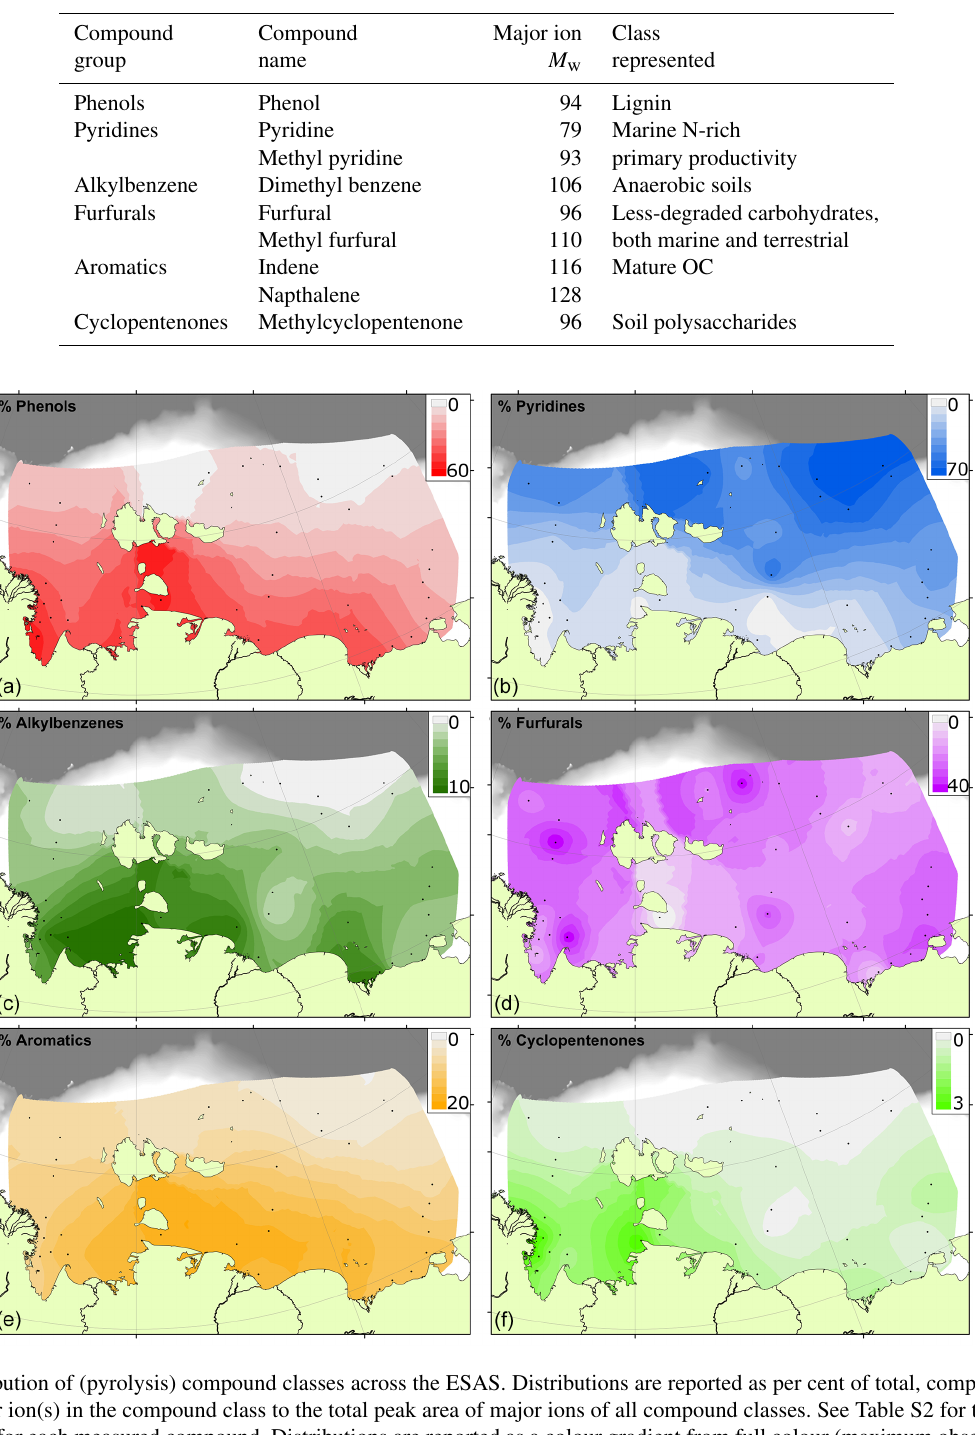
Table 1. Representative moieties analysed in this study, and the compound groups that they are interpreted to represent (after Guo et al., 2004).